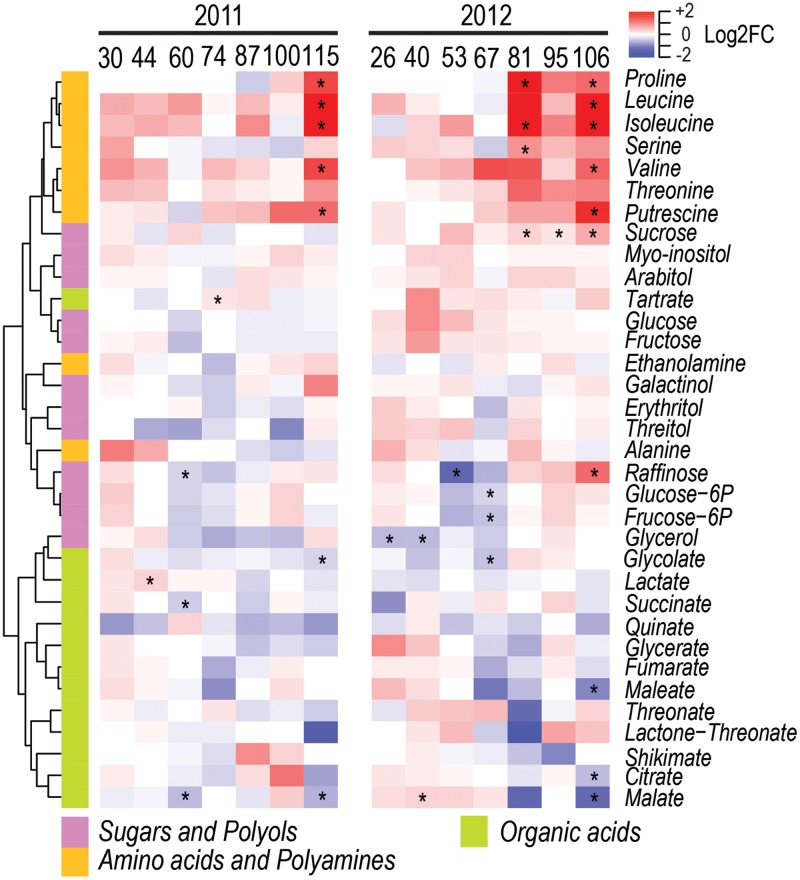
Impact of water deficit on central metabolites during berry development in 2011 (left) and 2012 (right). Heatmaps represent log2FC (WD/CT) at each developmental stage. Blue and red color shades indicate lower and higher metabolite concentration in WD than CT, respectively. Asterisks indicate significant differences (P < 0.05) between treatments. Metabolites were hierarchically clustered based on their response to water deficit. The colored side bar on the left indicates the class of metabolites.